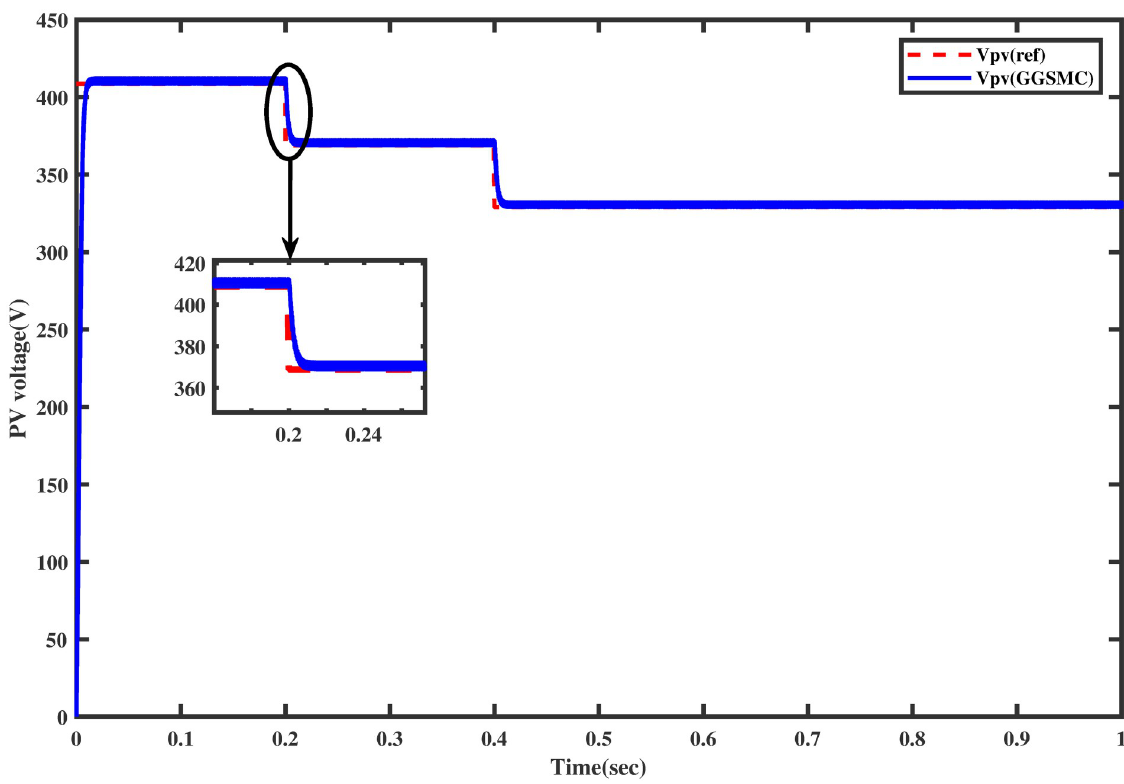
Fig 14. PV array power under varying